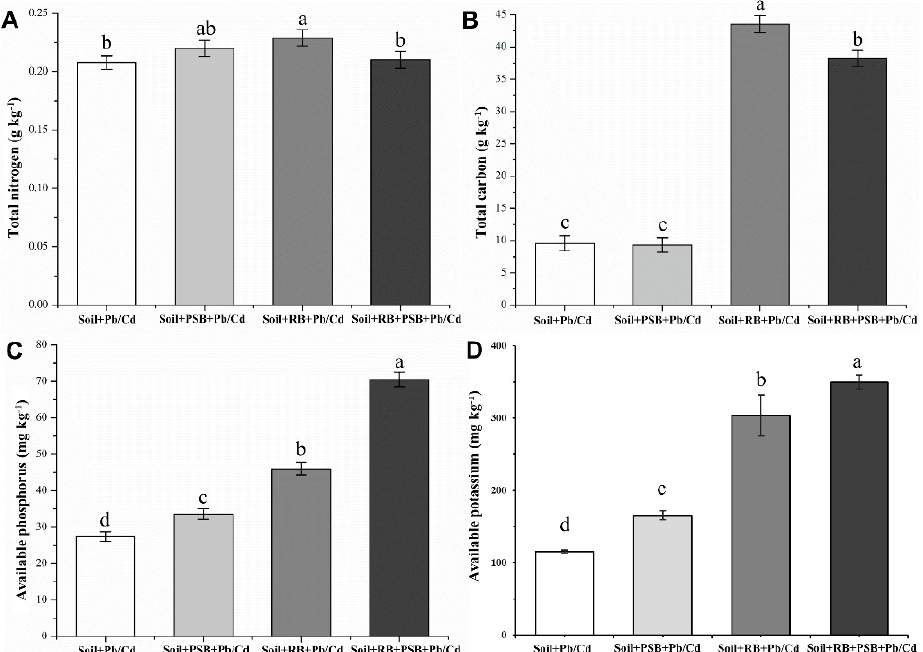
Figure 1. Nutrient element contents in soil with different treatments (( A ): Total nitrogen, ( B ): Total carbon, ( C ): Available phosphorus, ( D ): Available potassium, RB—rice husk biochar, PSB— Enterobacter sp.). Different letters indicate significant differences among treatments.